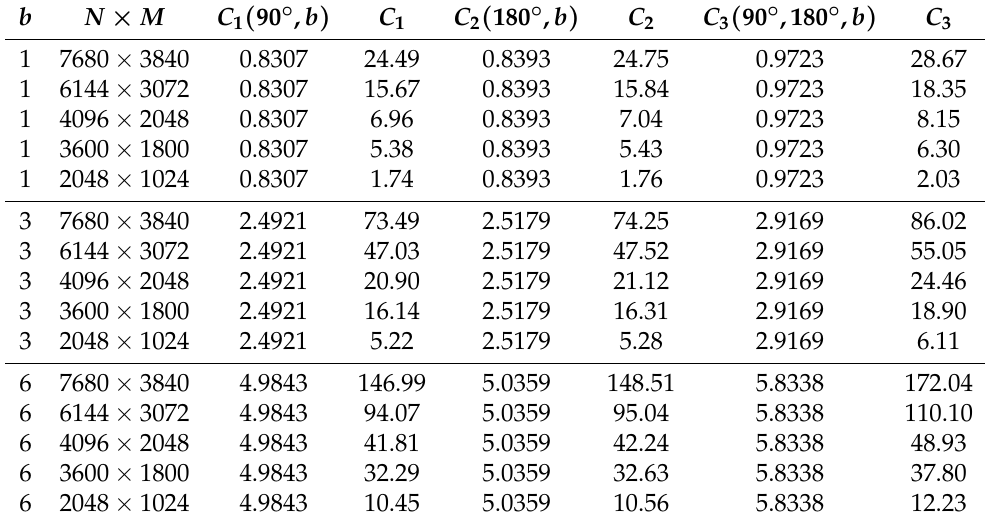
Table 3. Total capacity C 1 , C 2 , and C 3 provided by popular 360 ◦ video